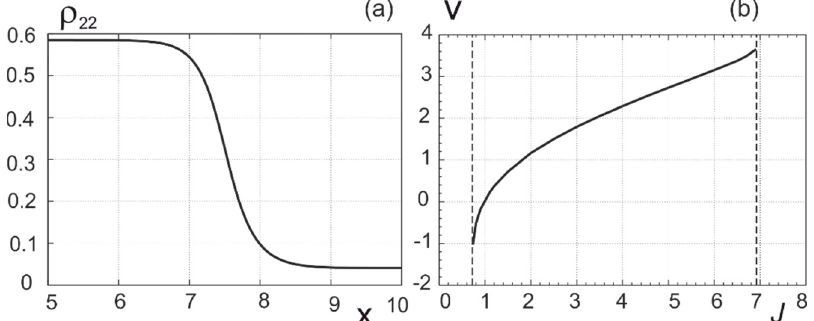
Figure 9. Instantaneous profile of population of excited state in the mode of switching wave ( a ) and dependence of the wave velocity on the radiation intensity ( b